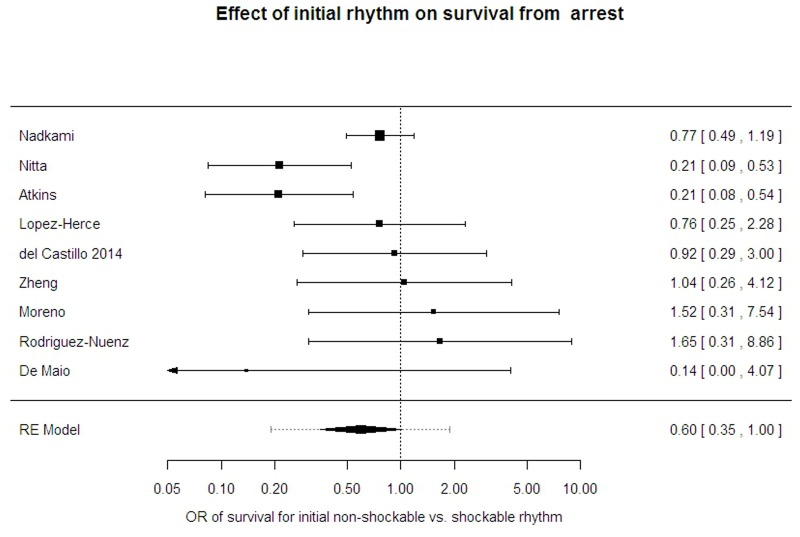
Effect of initial rhythm on survival from arrest.